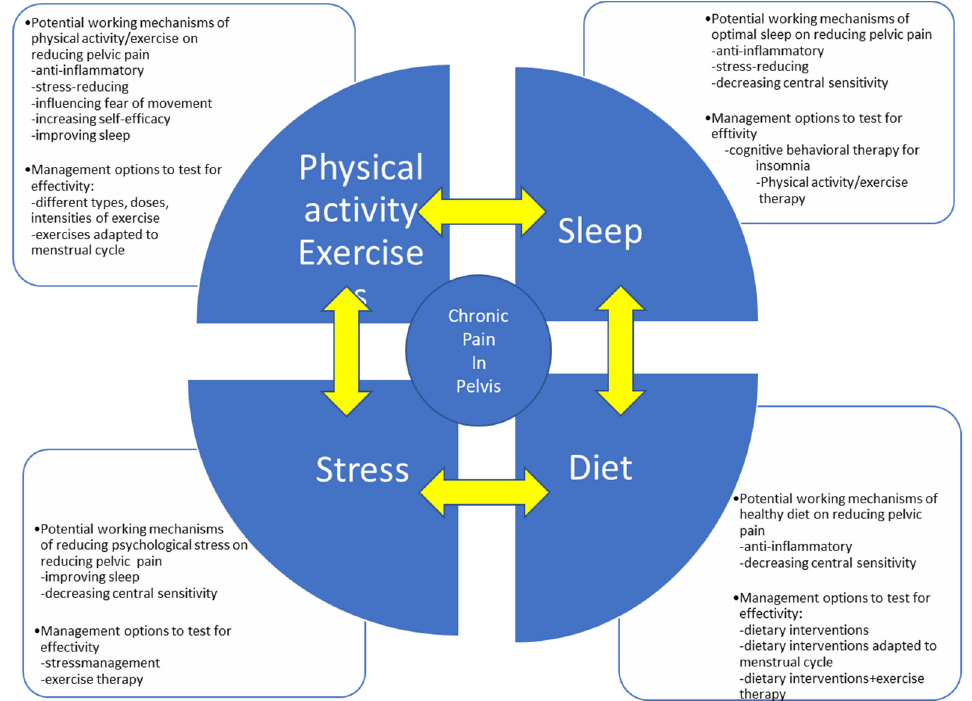
Figure 2. Research agenda of the potential working mechanisms of lifestyle factors on pain reduction in chronic pain in the pelvis, in parallel with potential management options.